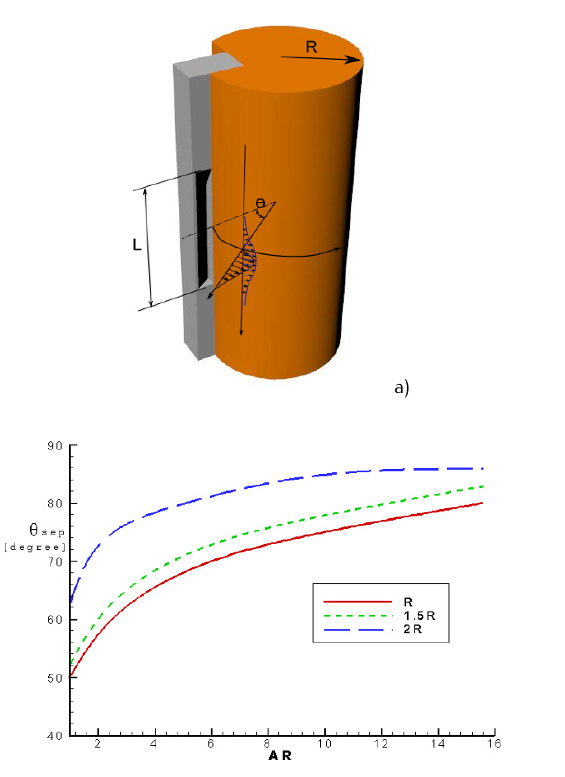
Figure 6. Schematic drawing representation of three-dimensional curved wall jet flow field a). Variation of center line sepa- ration angle with aspect ratio and radius of curvature b). Data compiled from [36].